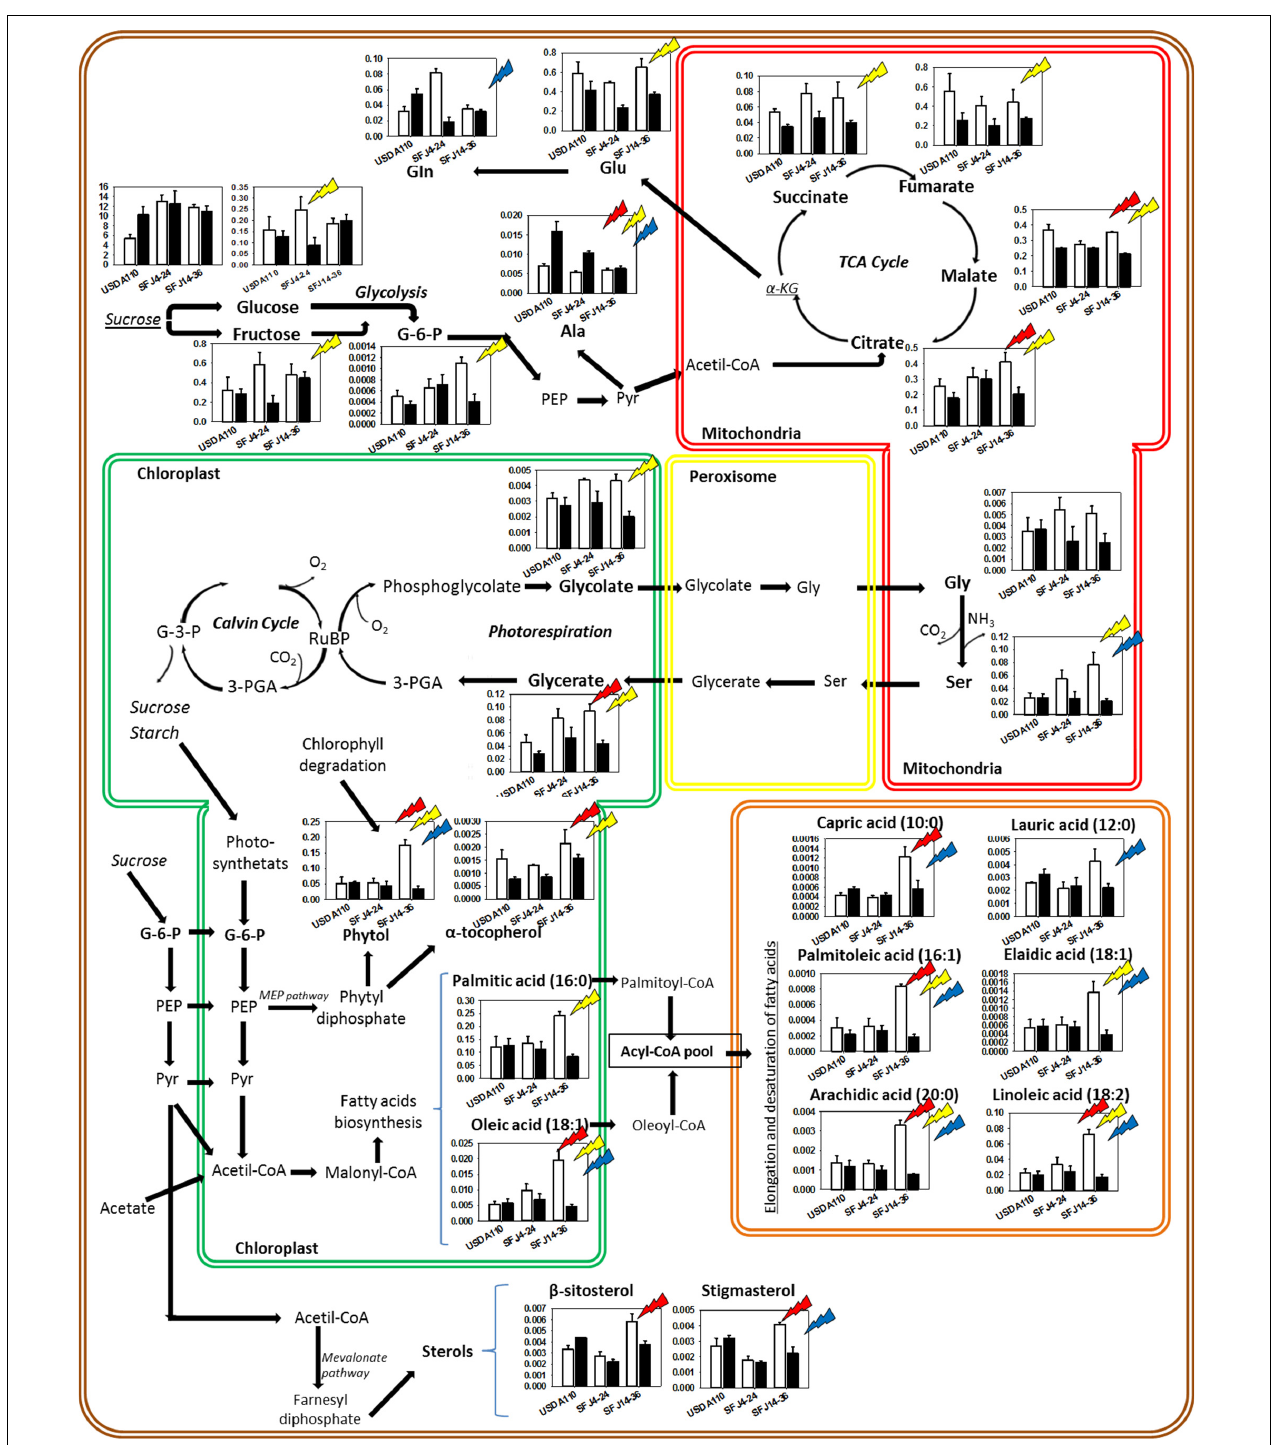
FIGURE 8 | Effects of Bradyrhizobium japonicum strain and [CO 2 ] on soybean leaf metabolism. Bar charts showing the relative abundance of metabolites in ambient [CO 2 ] (white) and elevated [CO 2 ] (black) in soybean plants inoculated with three different Bradyrhizobium japonicum strains. Red, yellow, and blue lightning signs indicate the significant effect of strain, CO 2 , and their interaction, respectively. Bold metabolites indicate metabolites analyzed that were found to have significant effect of strain, CO 2 and/or their interaction; italic metabolites indicate metabolites analyzed that were not found to have significant effect of strain, CO 2 , and their interaction, and not bold neither italic indicates metabolites not analyzed.